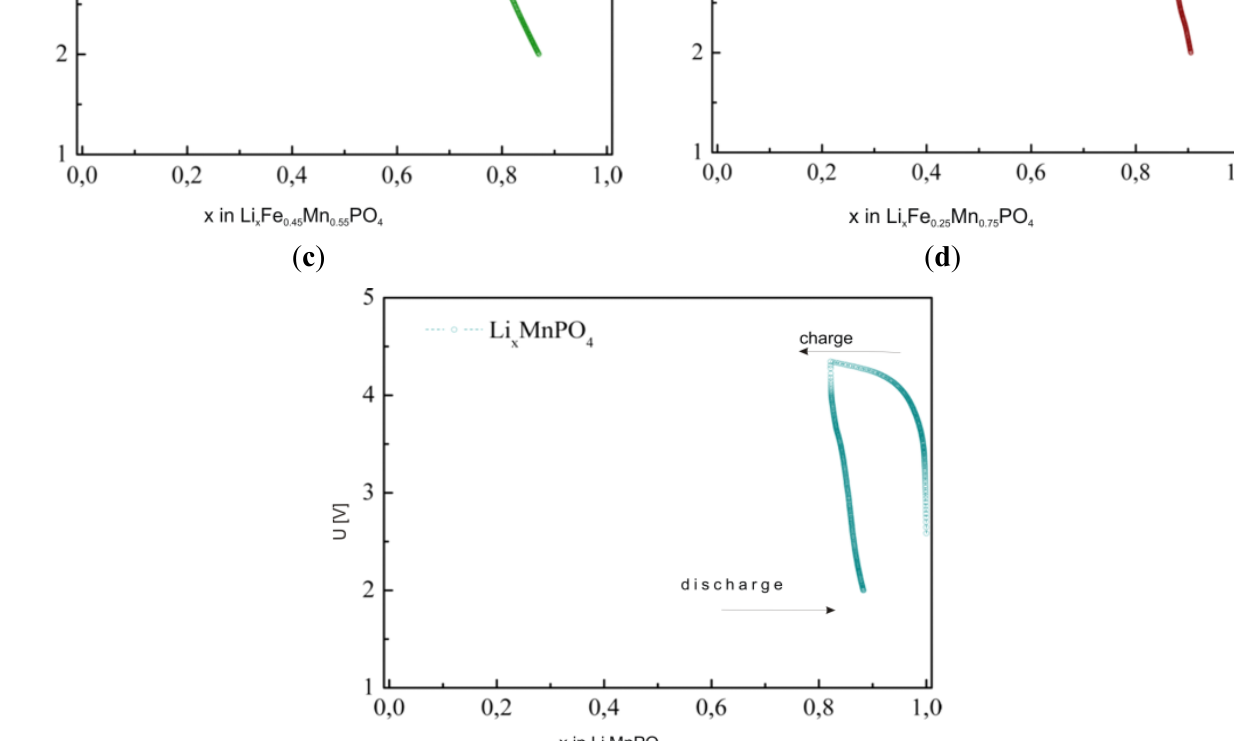
Fe Mn PO cells recorded with C/10 x 1 − y y 4